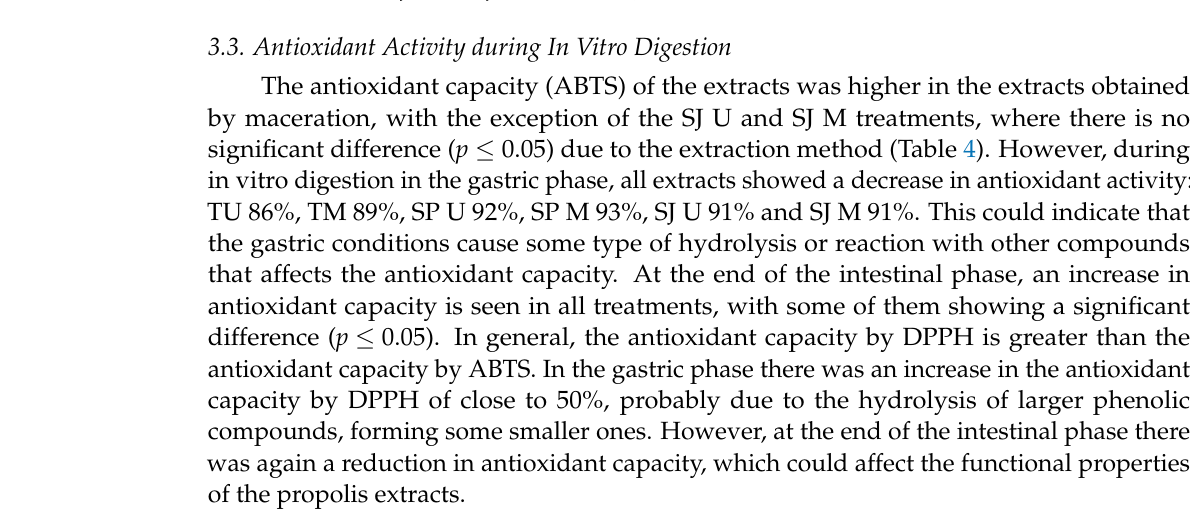
Table 4. Antioxidant activity of propolis extracts and their behavior during in vitro